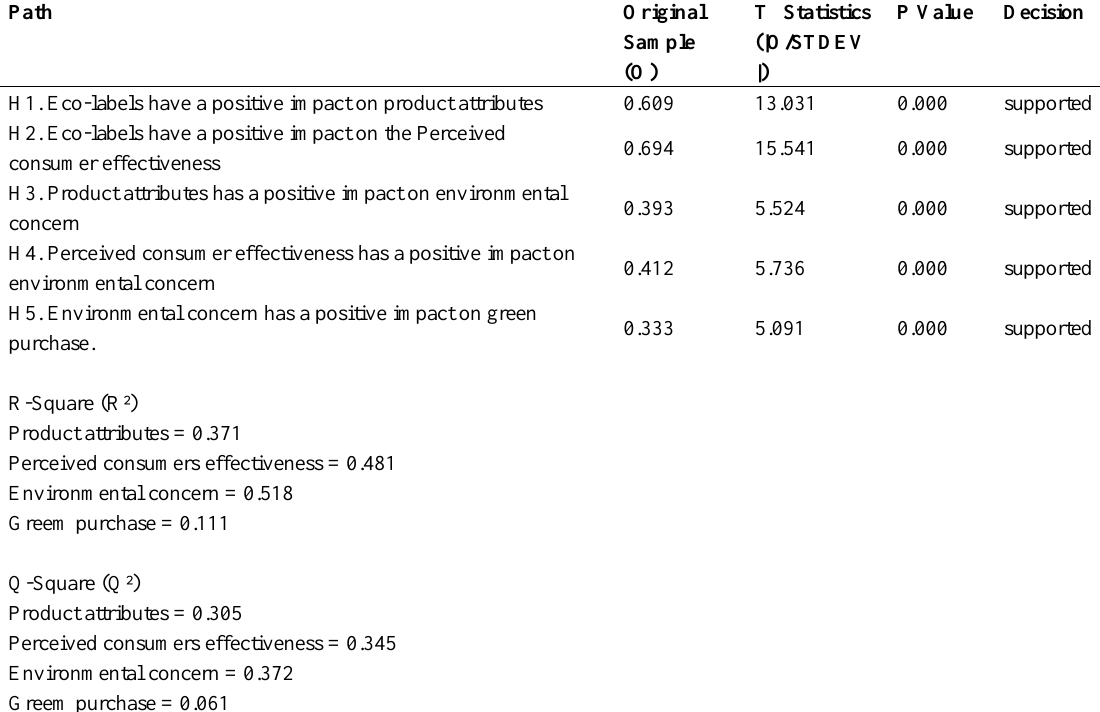
Table 3: Structural Model